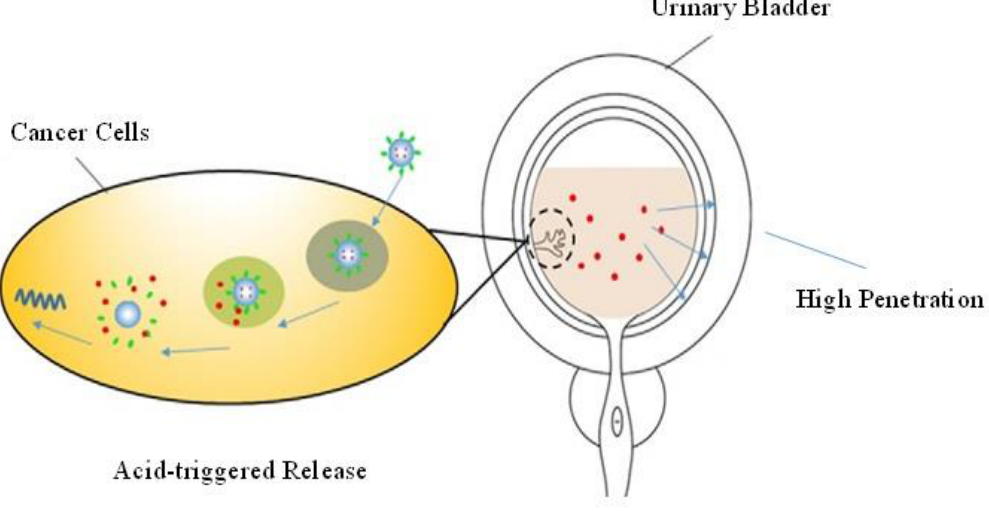
Figure 6. Site-specific action of drug release, using PEG-PAMAM-DOX as a dendrimer nanoparticle in IDD. Originally published by [146] and used with permission from Dove Medical Press Ltd.